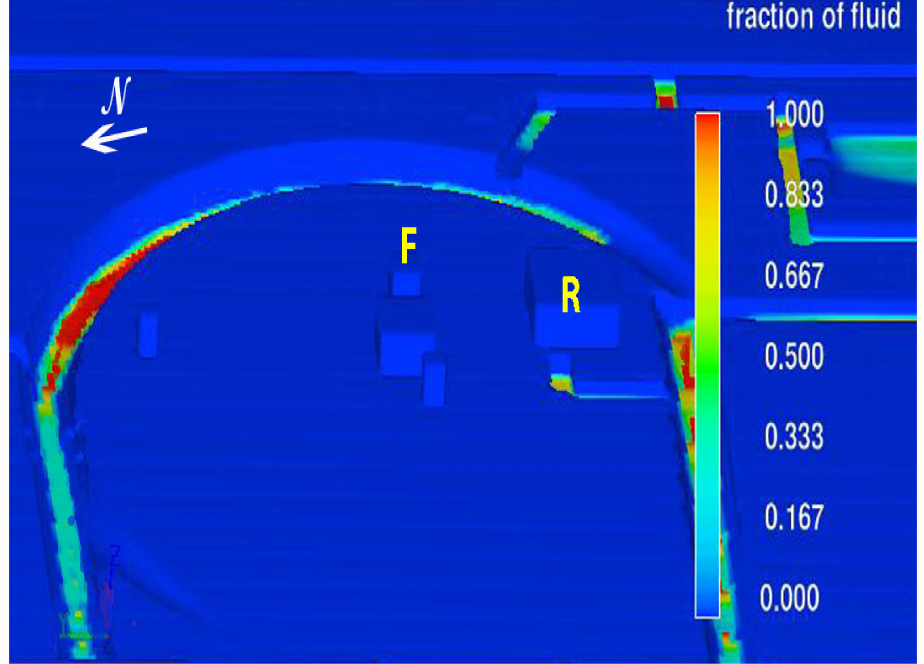
Figure 10. Late dry season (Case 2) fluid fraction results for the east arm of the perimeter drainage channel indicating dry season decreased seepage water into the perimeter drainage channel and extensive surface